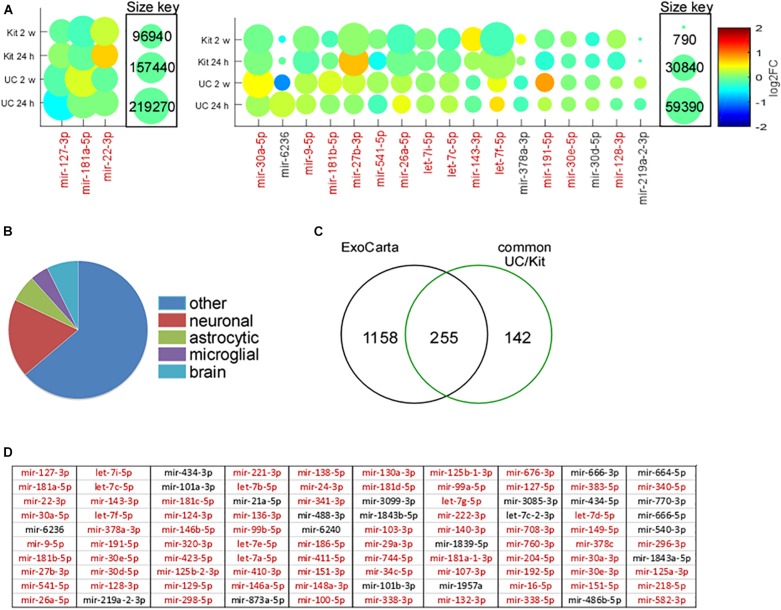
Abundance, cell origins, and ExoCarta analysis of EEF miRNA content. (A) Amounts of miRNAs identified by small RNA sequencing of EEFs from mouse hippocampus. MiRNAs are ordered on a Matlab-based visual graphic, according to average log2FC across all samples, from highest to lowest abundance. The size of the visual graphic bubble shows the number of reads (CPM) of each miRNA detected in the samples and its color represents the log2FC in KA relative to PBS control levels. Presented are the top 20 miRNA in the UC-derived EEFs, of which 16 are common across all 24 samples (in red). (B) Pie chart depicts the assignment of miRNA based on likely cell type for the common 397 miRNAs detected in both UC and kit EEFs. (C) Venn diagram showing overlap (∼64%; 255 of 397) of the detected miRNA with those listed in the exosome contents database, Exocarta. (D) Top 100 miRNA (most abundant based on average across all 12 samples in UC) expressed in EEFs from both UC and kit. The miRNAs colored red are listed in ExoCarta.